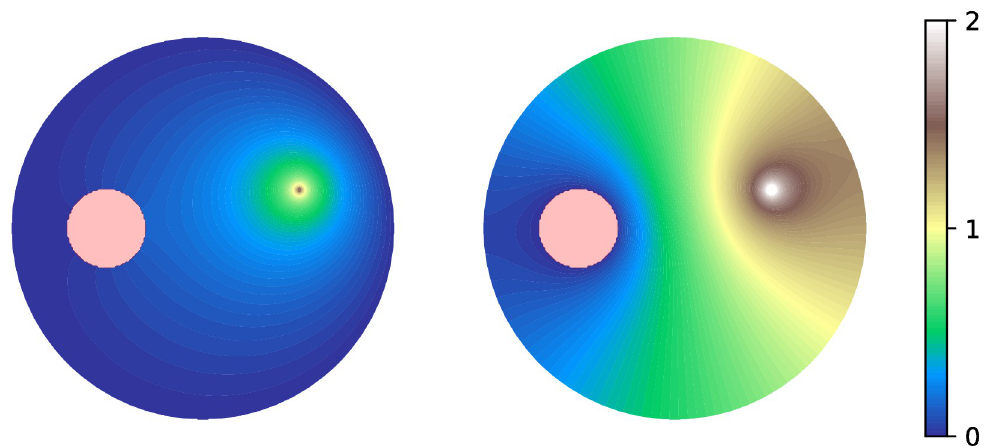
Fig 2. Exact Green’s functions. Left: G 1 ( x 0 , x ). The boundary of the unit circle is absorbing, the boundary of the inclusion is reflecting. Right: G 2 ( x 0 , x ). The boundary of the unit circle is reflecting, the boundary of the inclusion is absorbing. The initial position of the diffusing particle, x 0 , is displaced by (0.5, 0.2) from the center of the unit disk; the inclusion has radius 0.2 and is displaced by ( − 0.5, 0). The value of the function at x is the occupation density of the diffusing particle, until reaching the absorbing boundary. We use the closed expressions (12) and (13) that involve the Jacobi theta function. Python code is provided in the S1